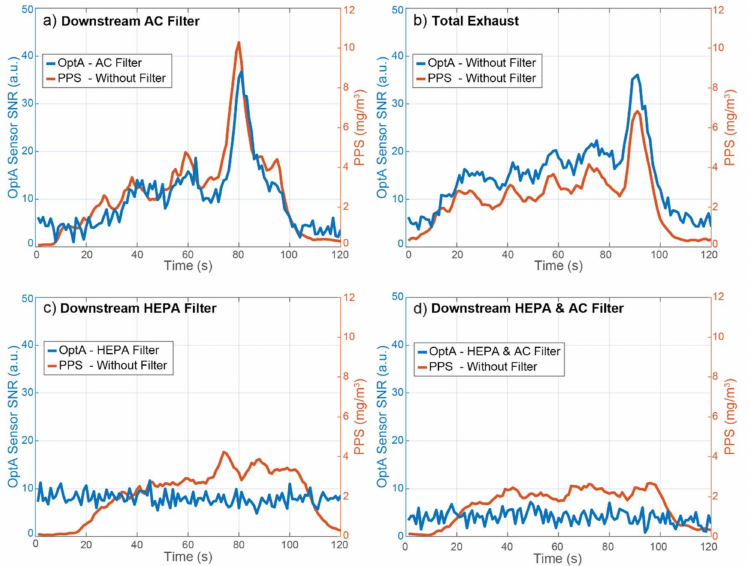
Figure 6. Sensor signal-to-noise ratio (SNR) in High Sooting Mode and comparison with a Pegasor Particle Sensor (PPS), used as a reference instrument. The PPS always received an unfiltered sample. ( a ) Optoacoustic (OptA) Sensor’s sample filtered by an Activated Carbon Filter, ( b ) total exhaust, ( c ) OptA sensor’s sample filtered by a HEPA filter, ( d ) OptA sensor’s sample filtered by a HEPA filter and an Activated Carbon